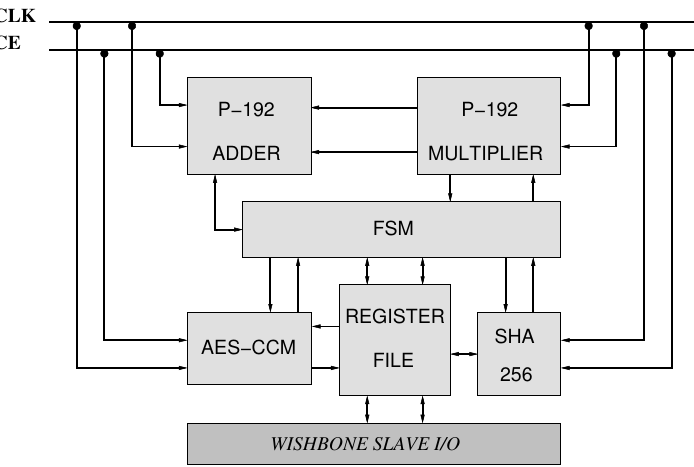
Figure 7. Organization of the P-192